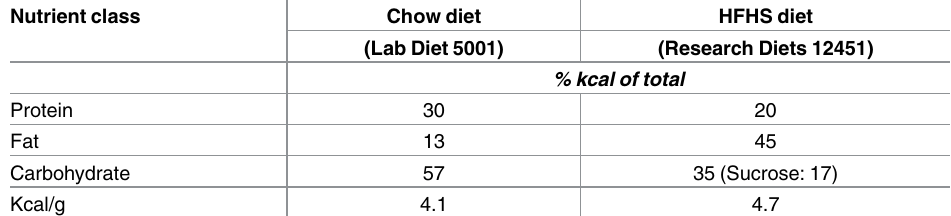
Table 1. Nutritional composition of